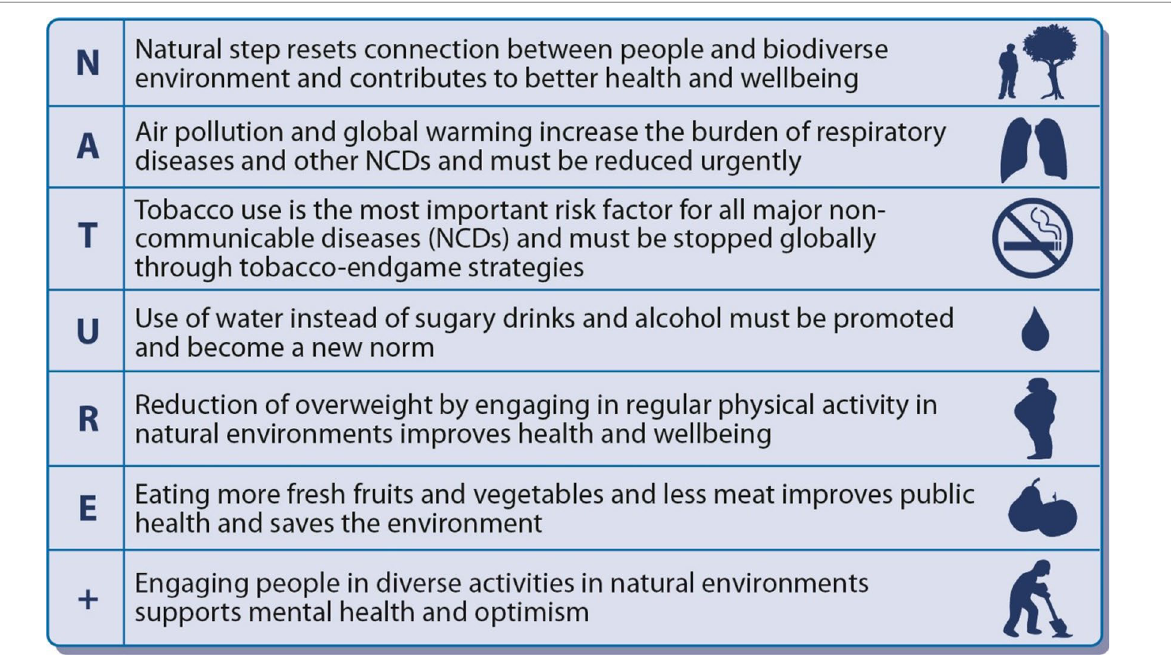
Fig. 3 Imperative actions to promote human health and conserve